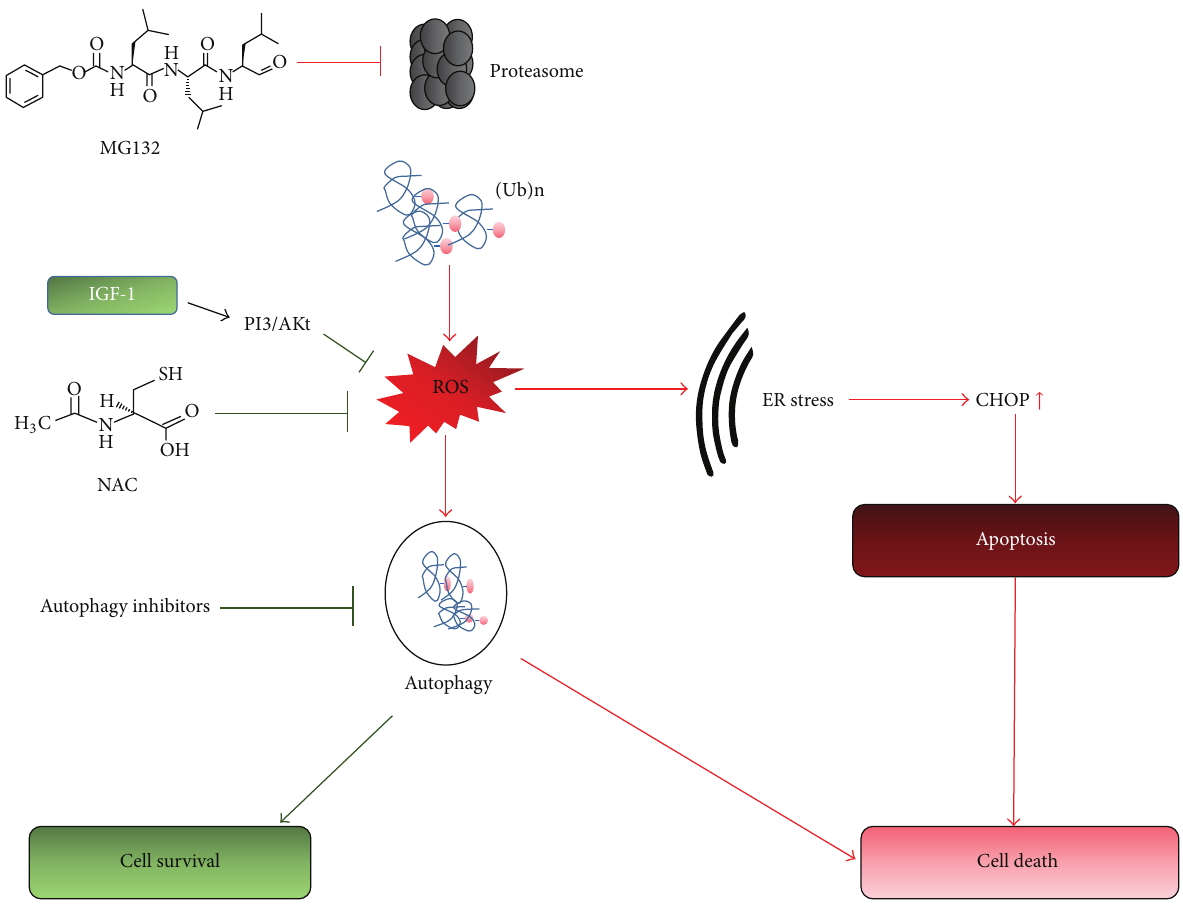
Figure 7: Schematic representation of molecular mechanisms of the proteasome inhibition induced cytotoxicity and its protection by NAC andIGF-1.Greenlinesrepresentcellsurvivalpathwaysandredlinesrepresentcellapoptoticandcelldeathpathways.Inhibitionofproteasome by MG132 increases the aggregation of damaged and misfolded proteins. The accumulation of misfolded protein in the cytosol activates downstream ROS accumulation, ER stress, and cell death. Neuroprotective effect against MG132 of NAC and IGF-1 involves involvement of multiple protective